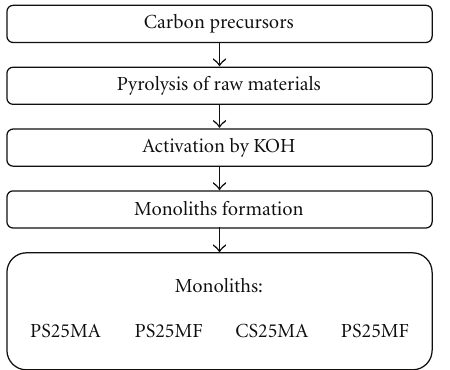
Figure 2: Preparation of carbon monoliths.